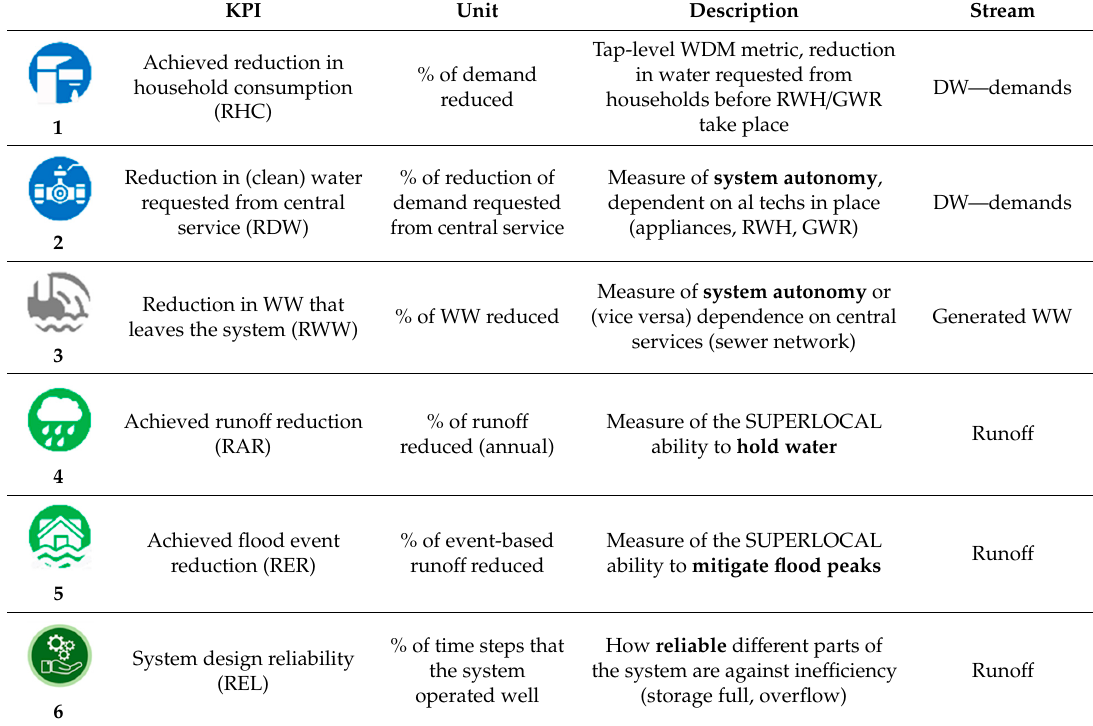
Table 3. The KPIs defined as part of the framework.